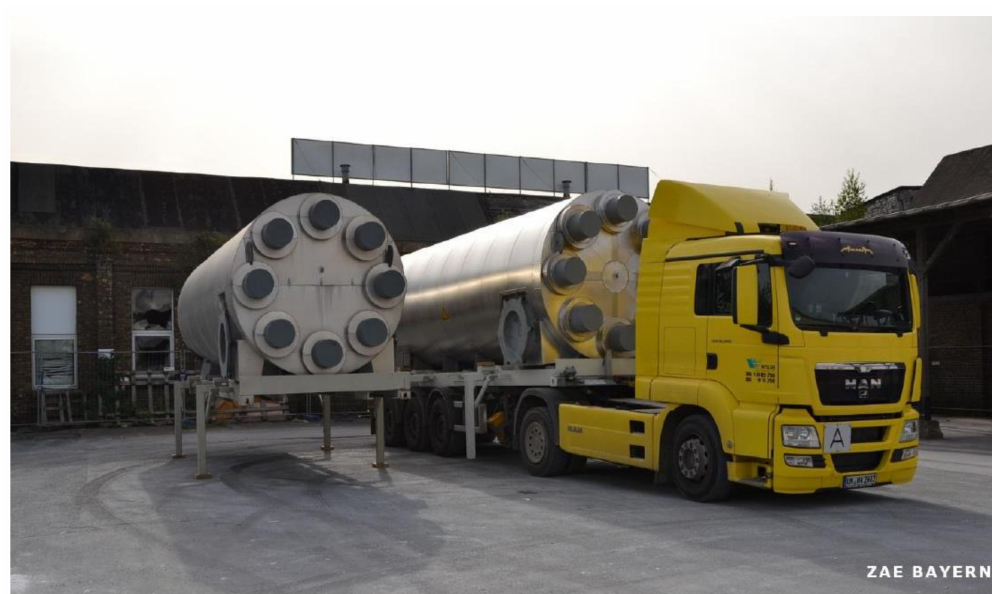
Figure 18. Stored energy delivering system at a discharge station [137].